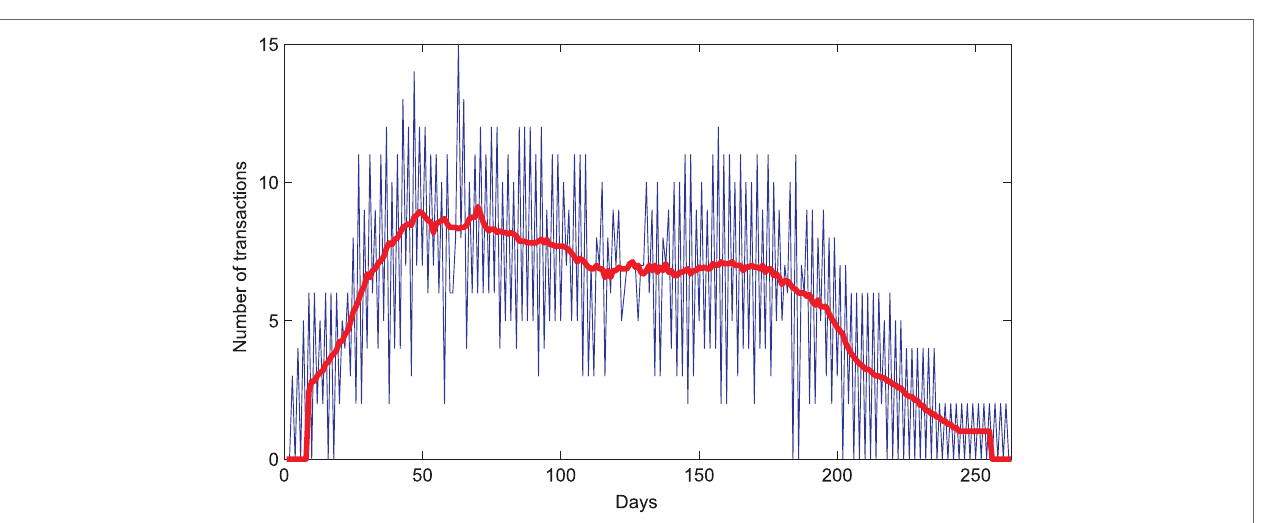
FigUre 18 | Total number of transactions between agents in days . The thick line represents the moving average with the window size equal to